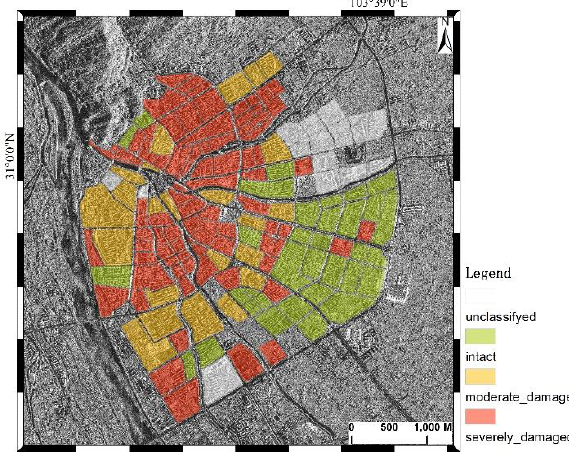
Figure 8. Building damage degree estimation in block